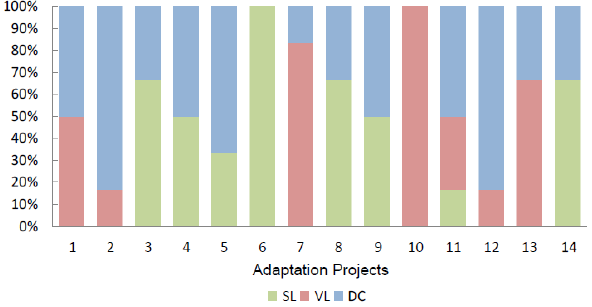
Figure 5. Adaptation frameworks utilised by each adaptation project (see Table A2).